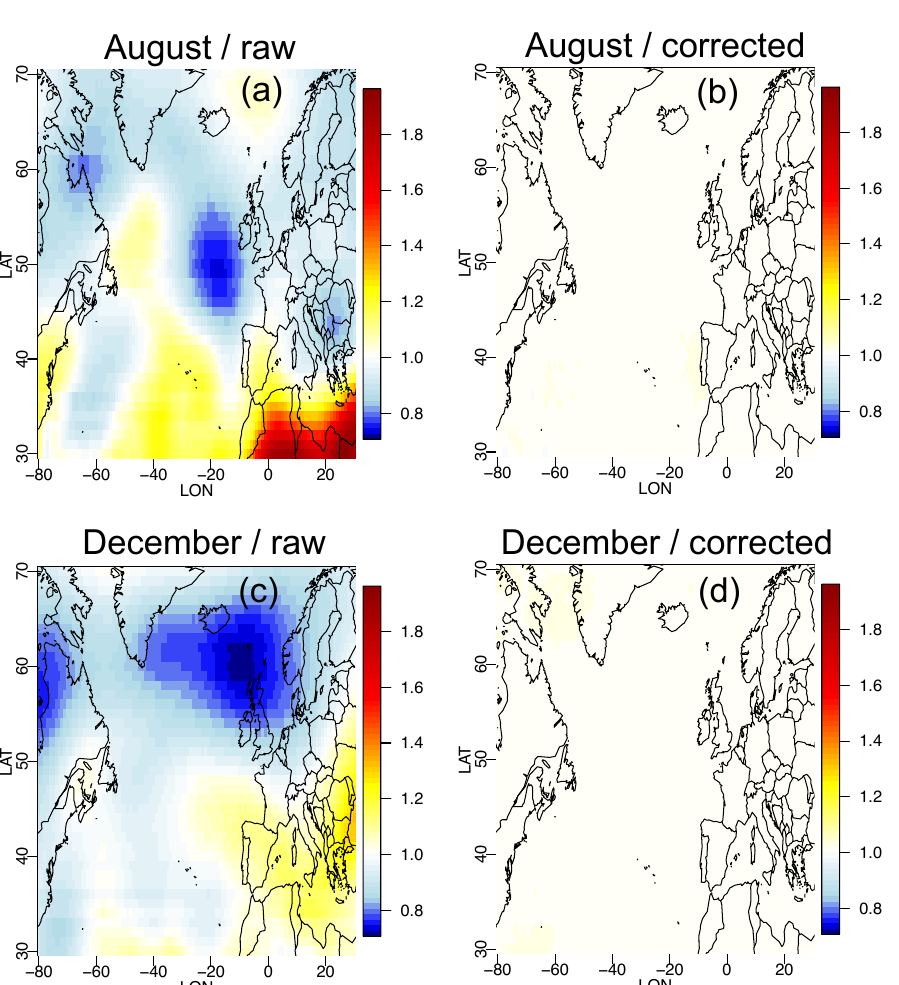
Figure A2. ( a ) Mean ratio of standard deviation of Z500 bias of 11 CMPI6 simulations for August. ( b ) Mean ratio of standard deviation of Z500 bias of 11 CMPI6 simulations after bias correction for August. ( c ) Mean ratio of standard deviation of Z500 bias of 11 CMPI6 simulations for December. ( d ) Mean ratio of standard deviation of Z500 bias of 11 CMPI6 simulations after bias correction for